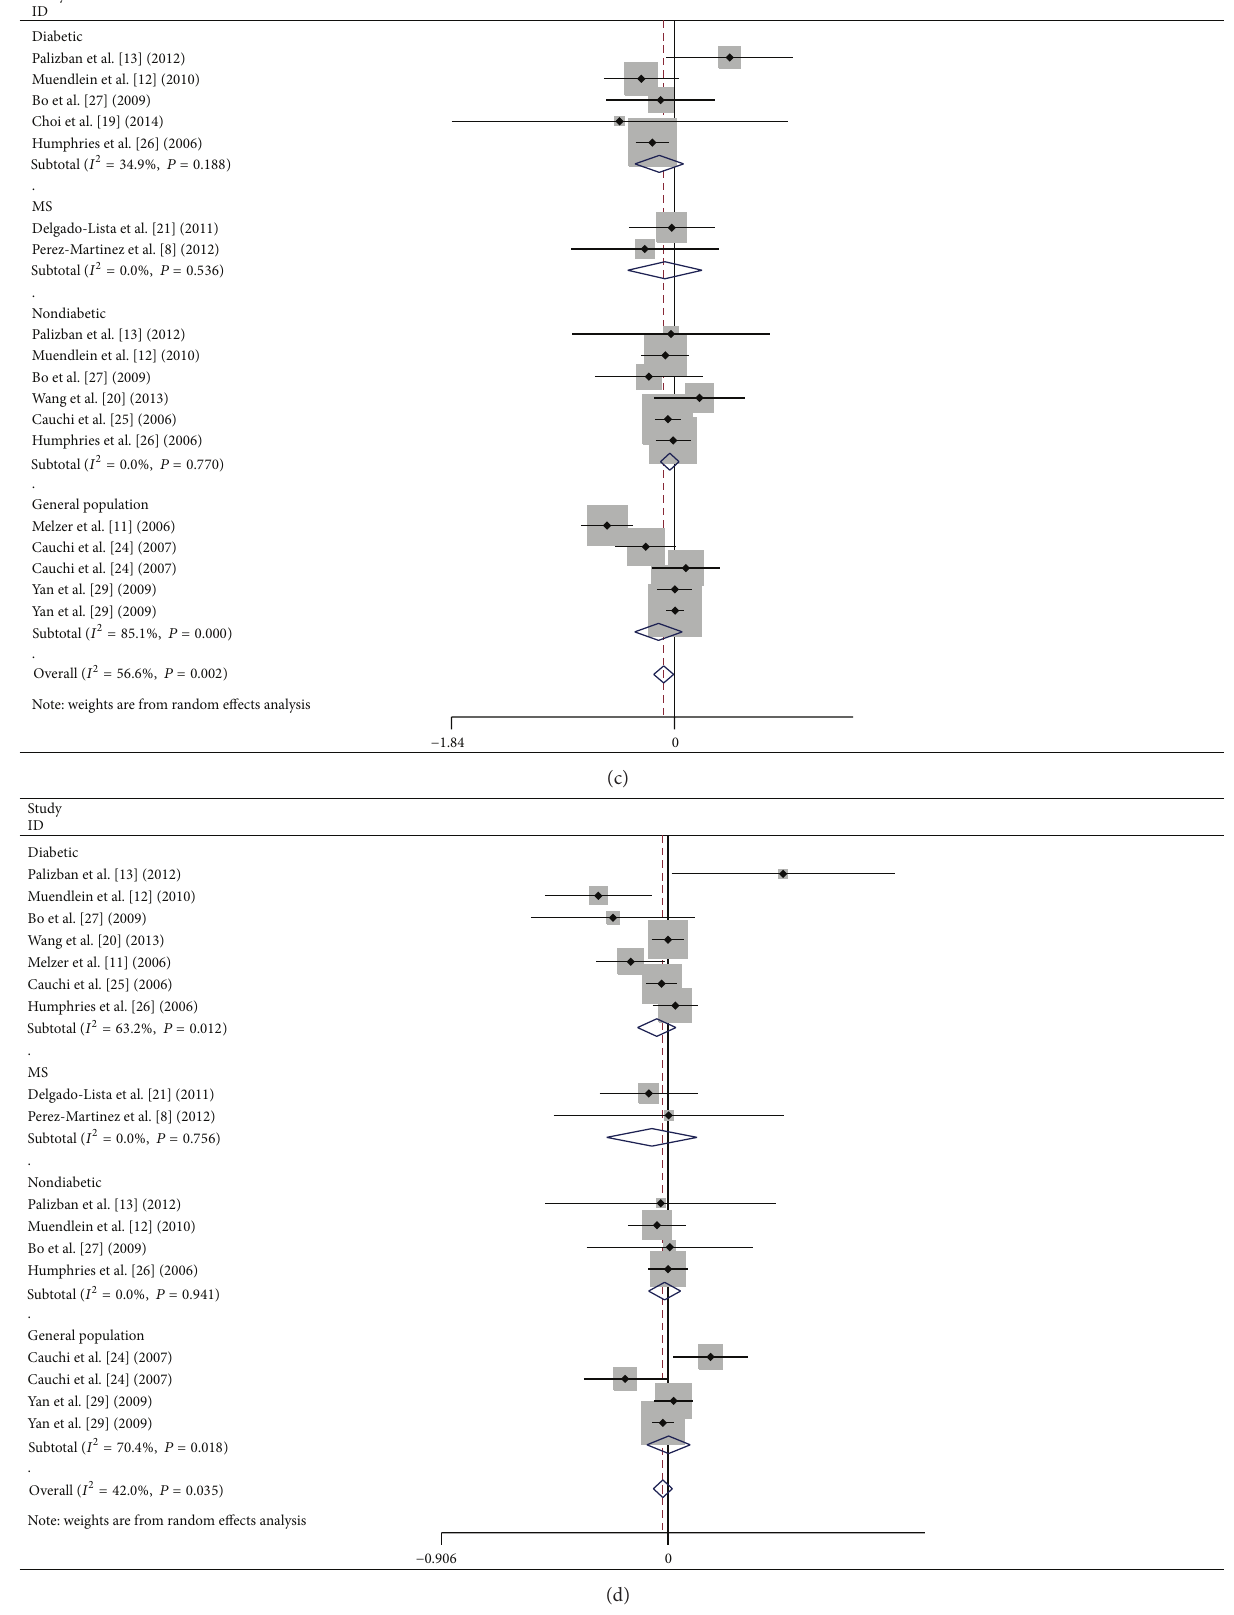
Figure 2: Forest plot of the TGCF7L2 rs7903146 polymorphism and triglyceride association: (a) dominant model, TT + TC versus CC, (b) recessive model, TT versus TC + CC, (c) homozygous model, TT versus CC, and (d) heterozygous model, TC versus